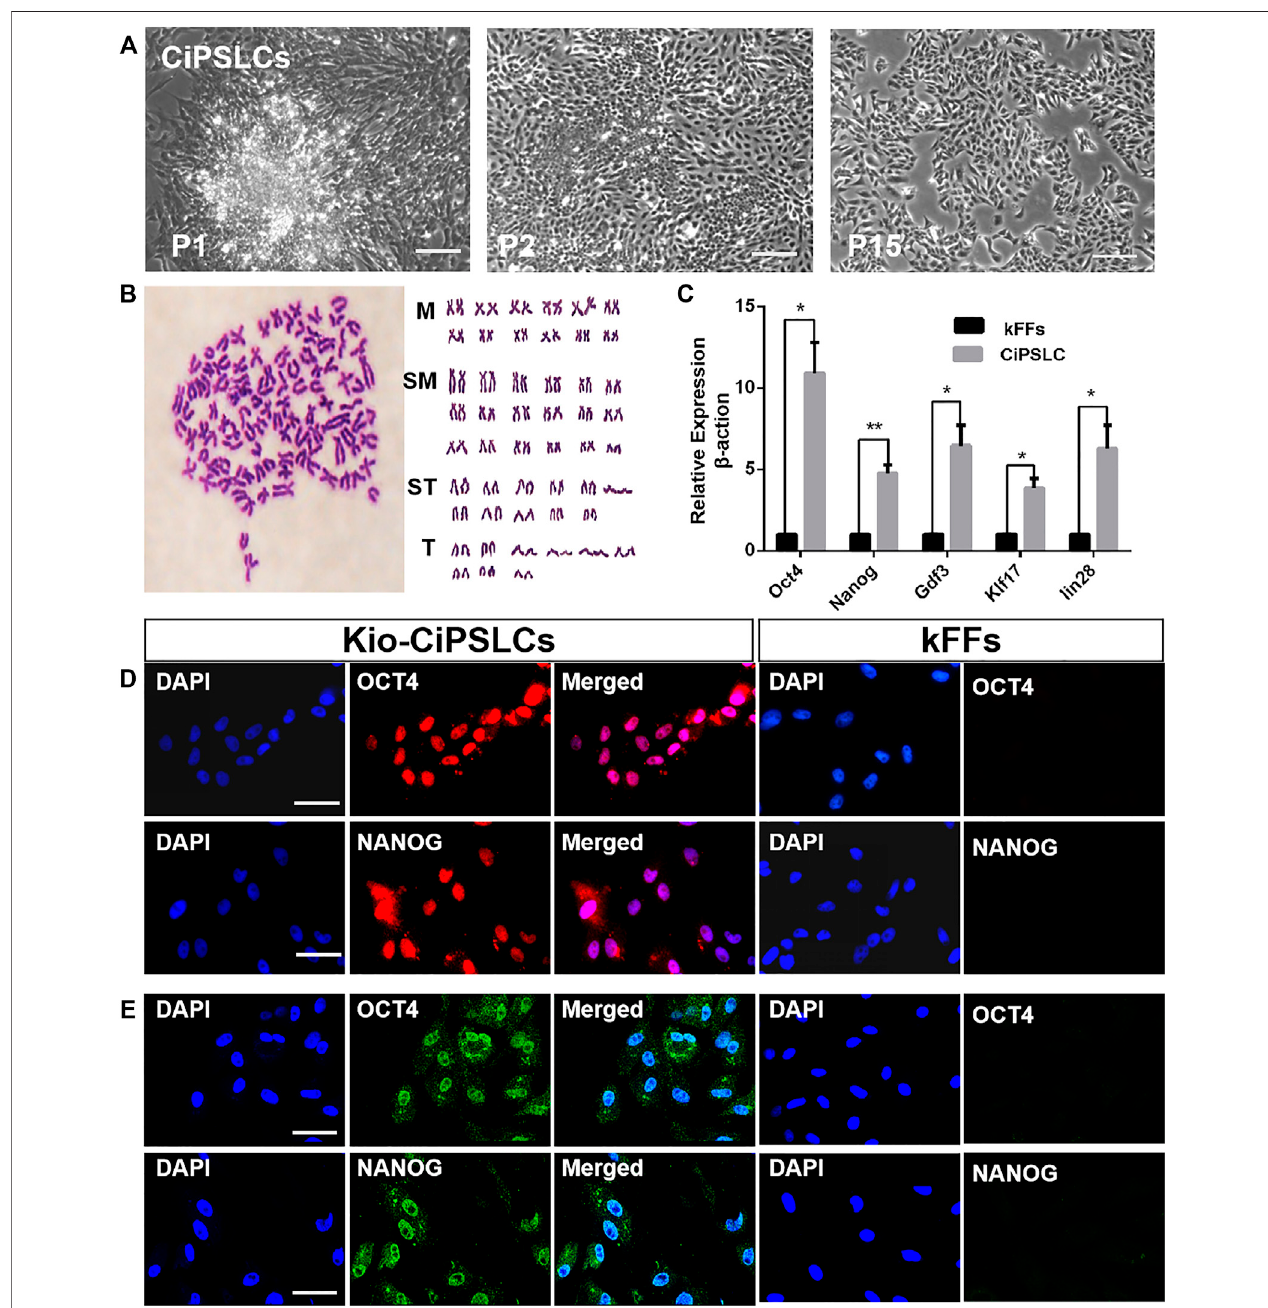
FIGURE2| CharacteristicsofKio-CiPSLCsderivedfromkFFs. (A) MorphologyofKio-CiPSLCsatpassage1,passage2andpassage15.After15coursesina fi sh stem cell culture medium, the stable ES cell-like morphology was maintained. Scale bars, 200 μ m. (B) Karyotype analysis of Kio-CiPSLCs at passage 20. Kio-CiPSLCs maintainednormalkaryotype,diploidmetaphaseof100chromosomesasseeninthemajorityofKio-CiPSLCs. (C) TheqRT-PCRanalysisofESmarkergeneexpression inKio-CiPSLCsandkFFsascontrol.ClearlyshownthattheexpressionofpluripotentgenesinKio-CiPSLCswassigni fi cantlyhigherthanthatinkFFs.*, p < 0.05,**, p < 0.01. (D,E) RNAprobehybridization (D) andimmuno fl uorescencestaining (E) ofOct4and N anog inKio-CiPSLCs(passage15),kFFsascontrol.Scalebars,50 μ m.